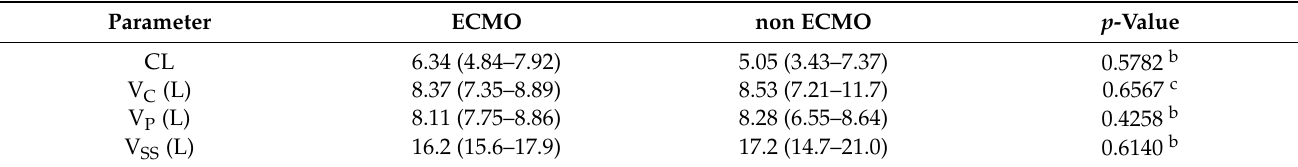
Table 3. Comparison of population PK parameter estimates between the ECMO and the non ECMO